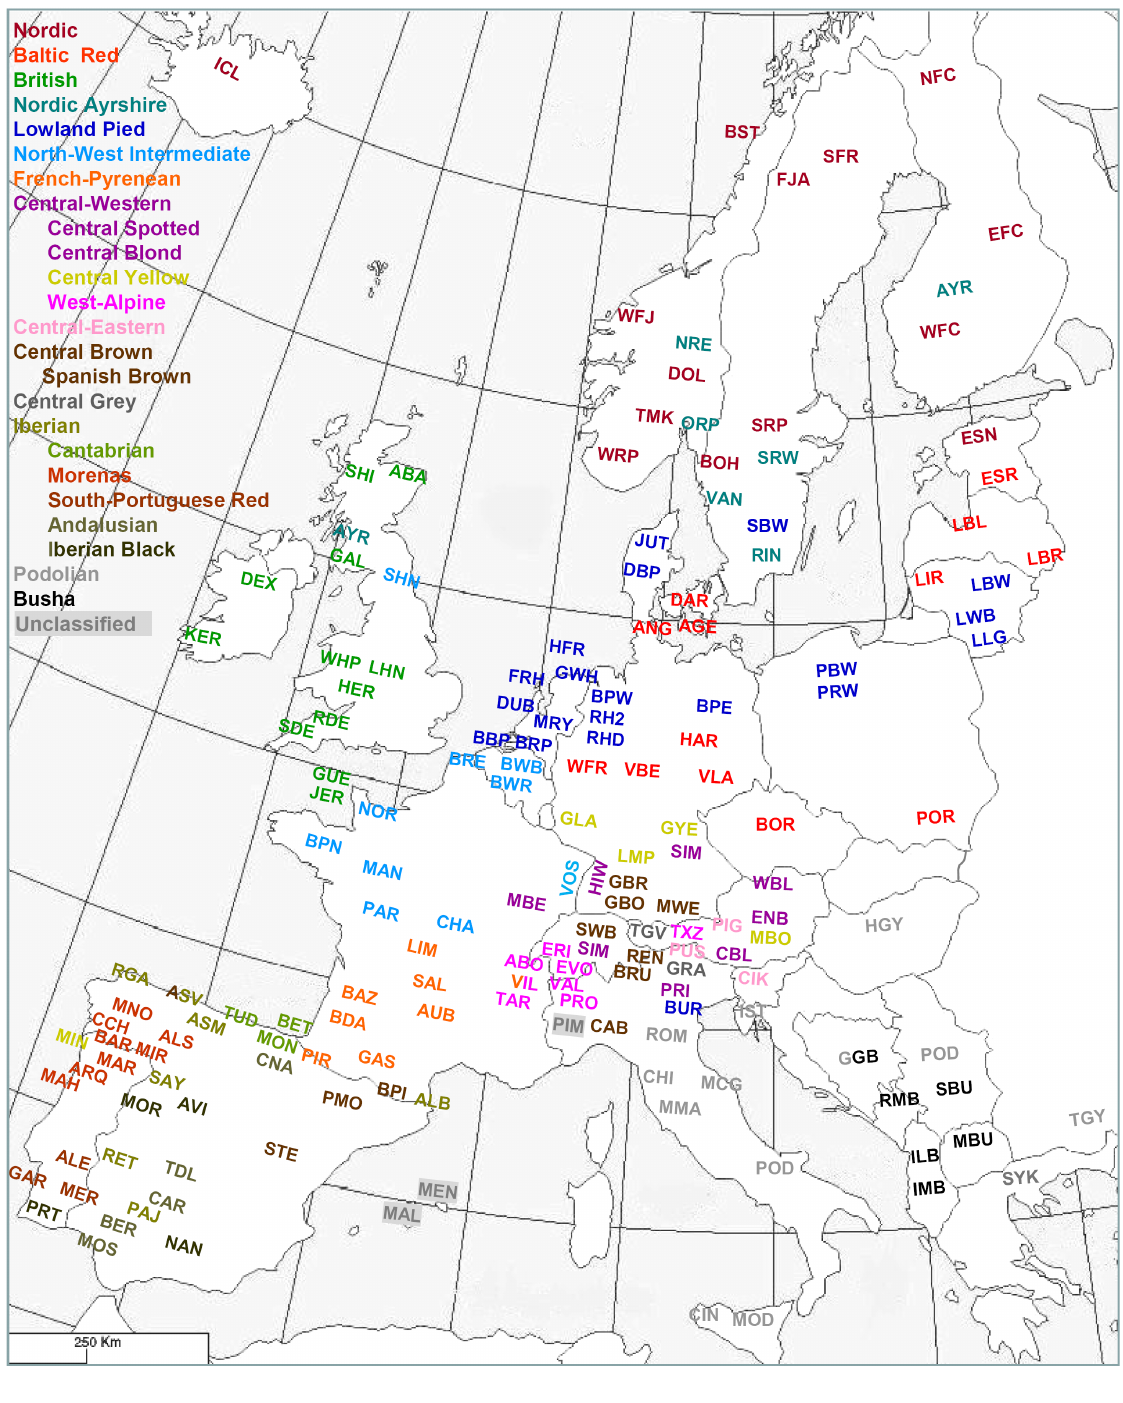
Figure 9. Categorization of European cattle on the basis of microsatellite genotyping. (Table S34). The Eastern and Eastern crossbred categories from Russia are outside the range of this map. Breed codes are as in Figure 8. Colors indicate clusters or subclusters and for breeds ASV, GGB and VIL intermediate